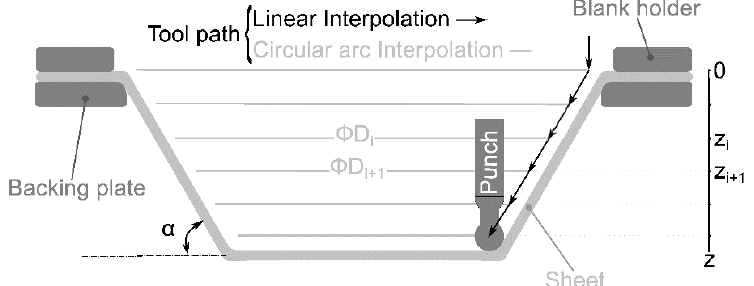
Figure 1. Single point incremental forming scheme and tool path implemented for the numerical and experimental tests accomplished in this work.